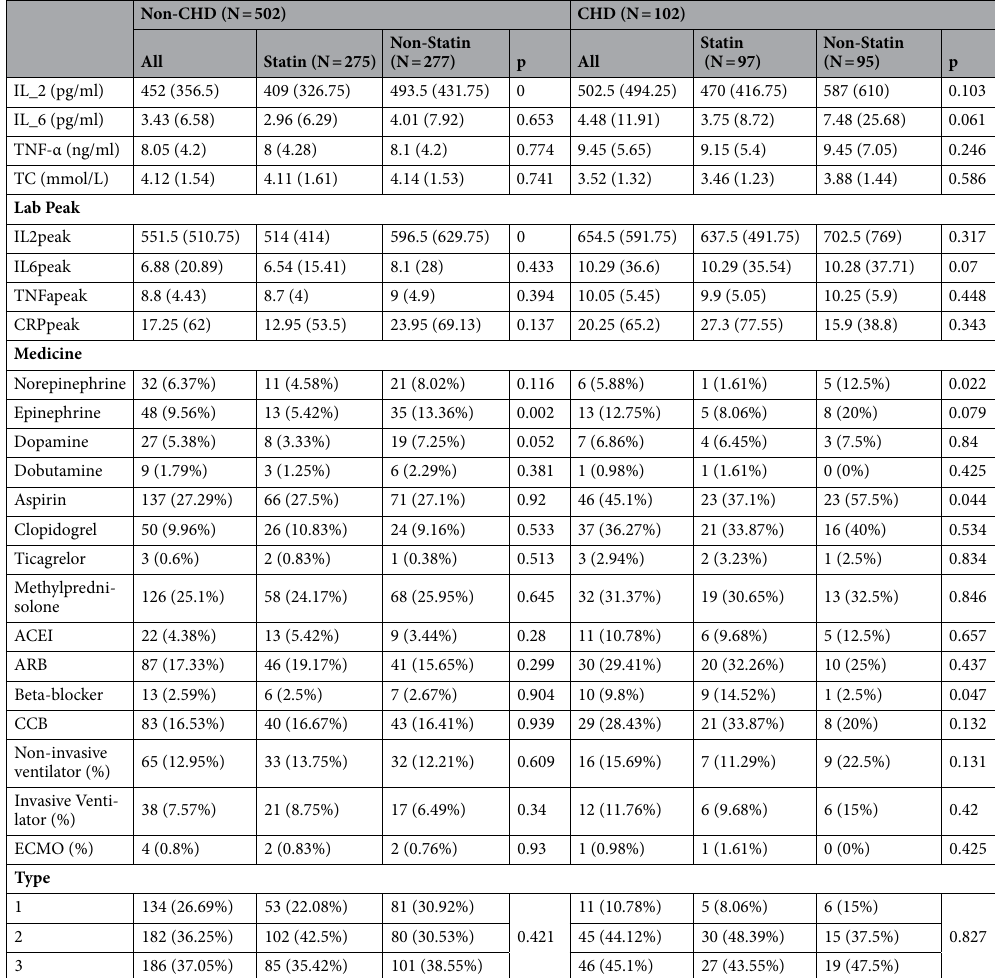
Table 4. Baseline characteristics of the study population according to statin use in CHD or non-CHD population after PSM. CHD, coronary heart disease; BNP, serum B-type natriuretic peptide; TNI, Troponin I; ALT, Alanine Aminotransferase; AST, Aspartate transaminase; Cr, Creatinine; ALB, Albumin; LDH, Lactate dehydrogenase; WBC, White blood cell; Lymph, Lymphocyte; Plt, Platelet; CRP, C Reactive Protein; IL-2, Interleukin 2; IL-6, Interleukin 6; TNF-α, P.C.T., Procalcitonin; Tumor necrosis factor-α; APTT, activated partial thromboplastin time; INR, international normalized ratio; TC, Total Cholesterol; ACEI, Angiotensin- converting-enzyme inhibitors; ARB, angiotensin receptor blockers; CCB, Calcium Channel Blocker; ECMO, Extracorporeal membrane oxygenation. Continuous variables are presented as median (IQR), categorical variables are presented as n